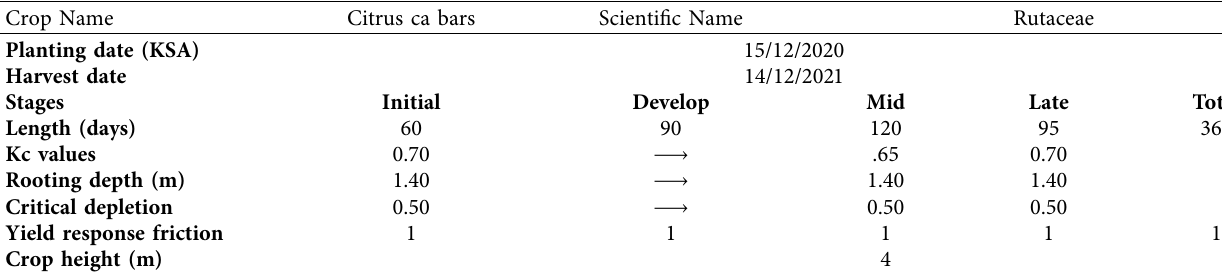
Table 9: The Citrus crop data at various stages.